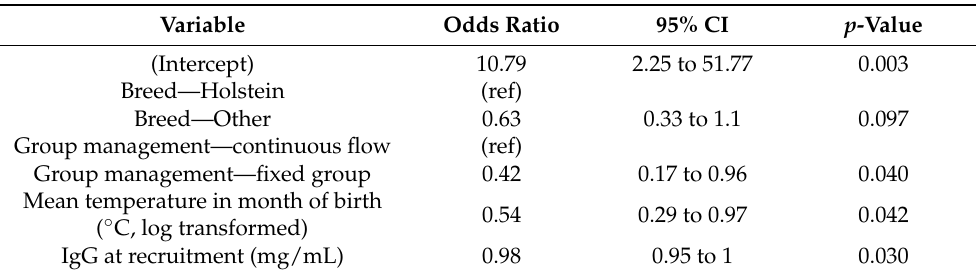
Table 3. Results of the generalised linear mixed model for variables associated with the risk of dairy heifers ( n = 492 on 11 farms) showing clinical signs of bovine respiratory disease (BRD) in their first nine weeks of life. Results are exponentiated odds ratios.